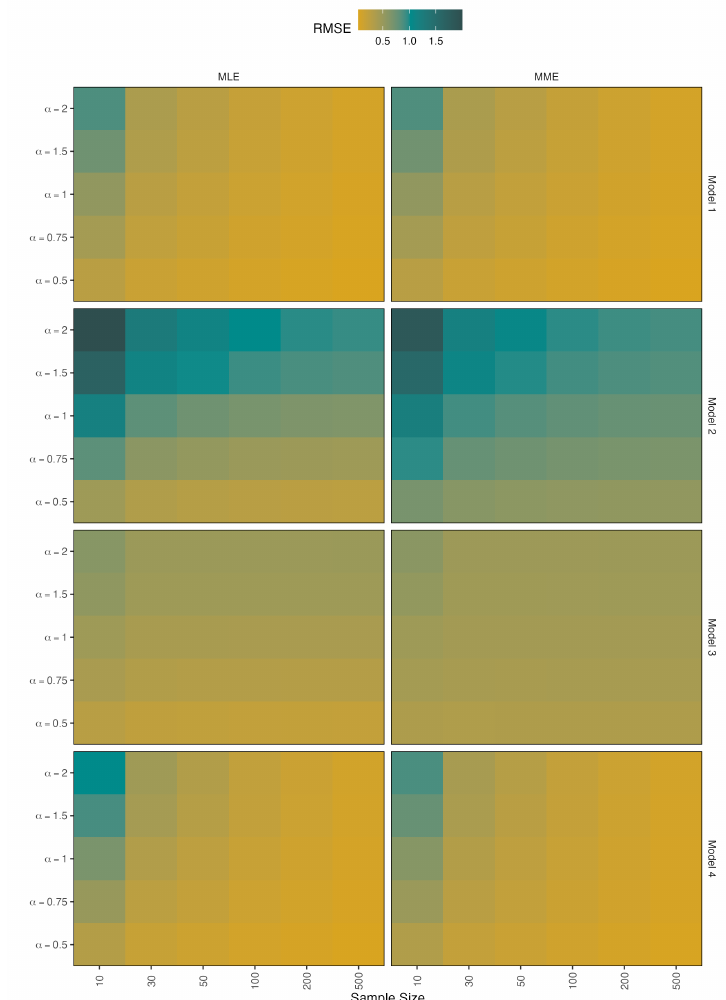
Figure 8. Simulated RMSEs for the estimators of β .